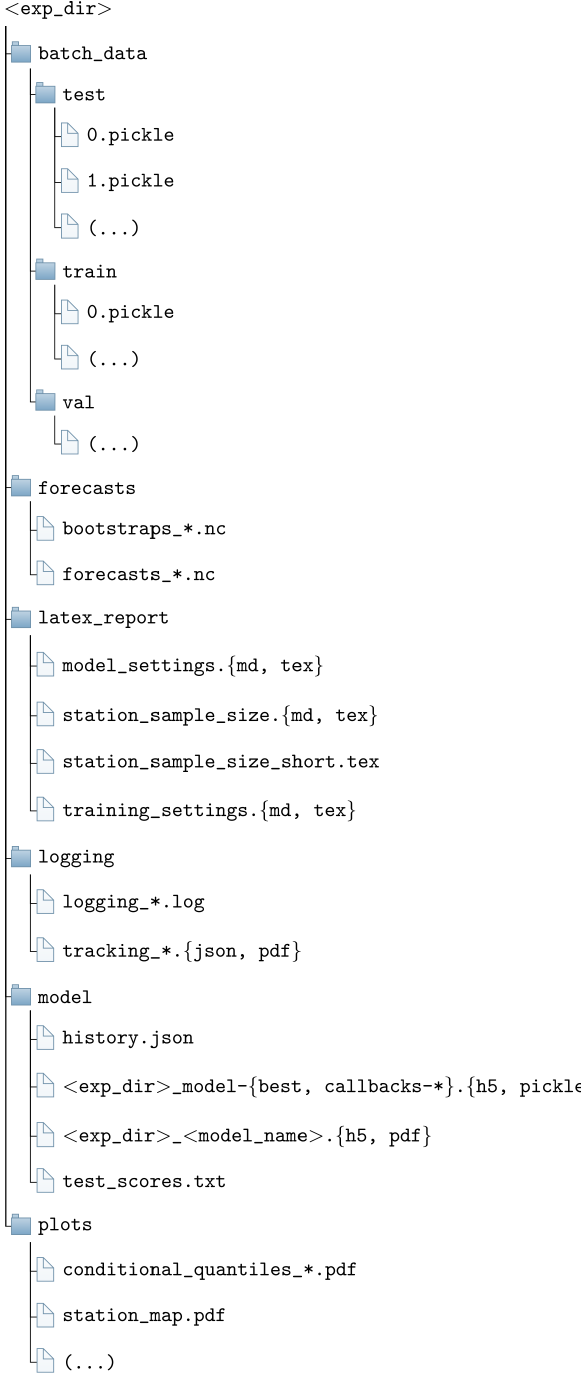
Figure 5. Default structure of each MLAir experiment with the sub- folders forecasts , latex_report , logging , model , and plots . <exp_dir> is a placeholder for the actual name of the experiment.